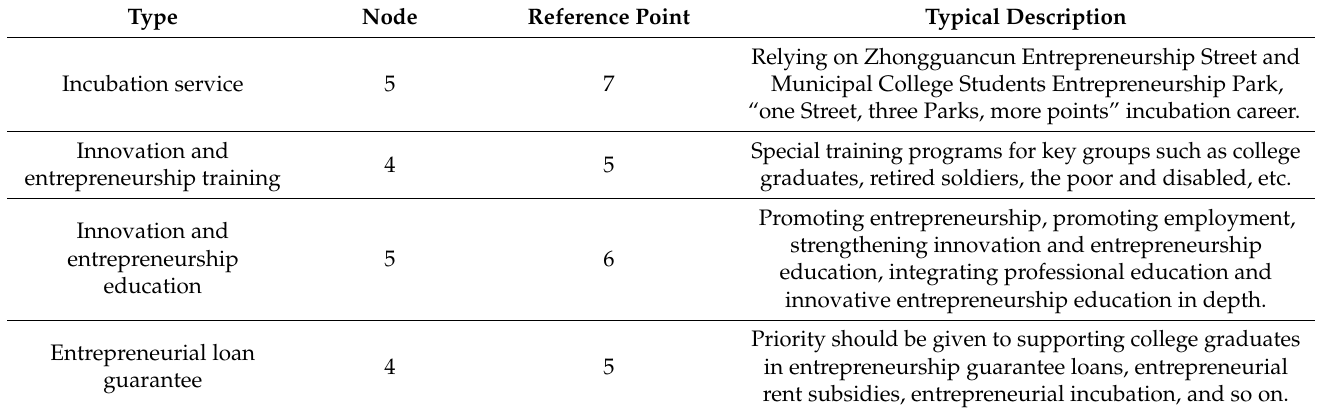
Table 2. Innovation and entrepreneurship drive